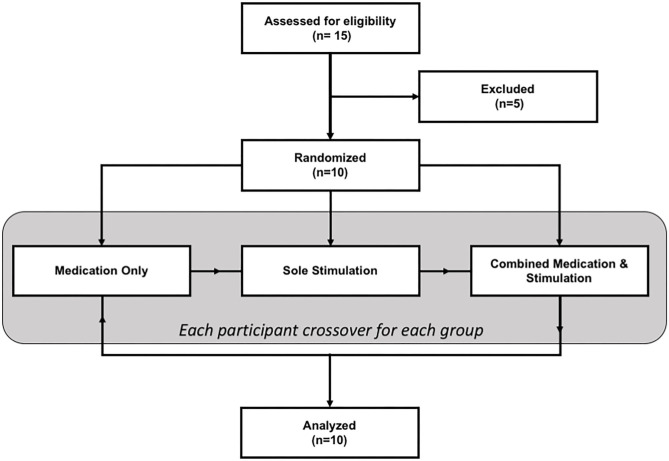
The CONSORT flow chart of the study.